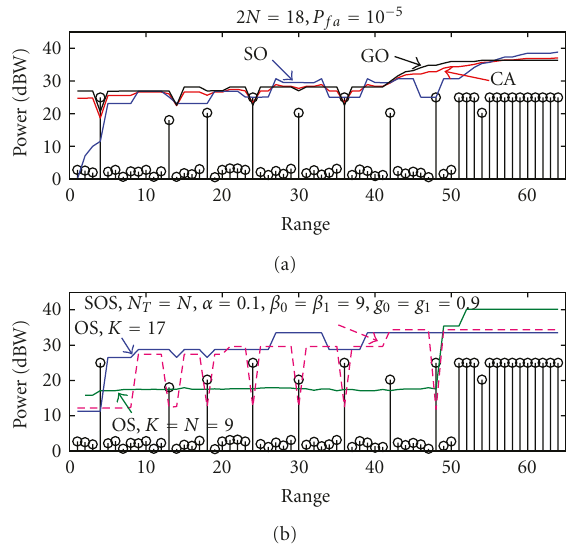
Figure 13: Detection thresholds of CA, GO, SO, OS ( k = N = 9 and 17), and SOS I ( N T = N , α = 0 . 1, β 0 = β 1 = 9, and g 0 = g 1 = 0 . 9) in worse case (2 N = 18 and P fa = 10 − 5 ).